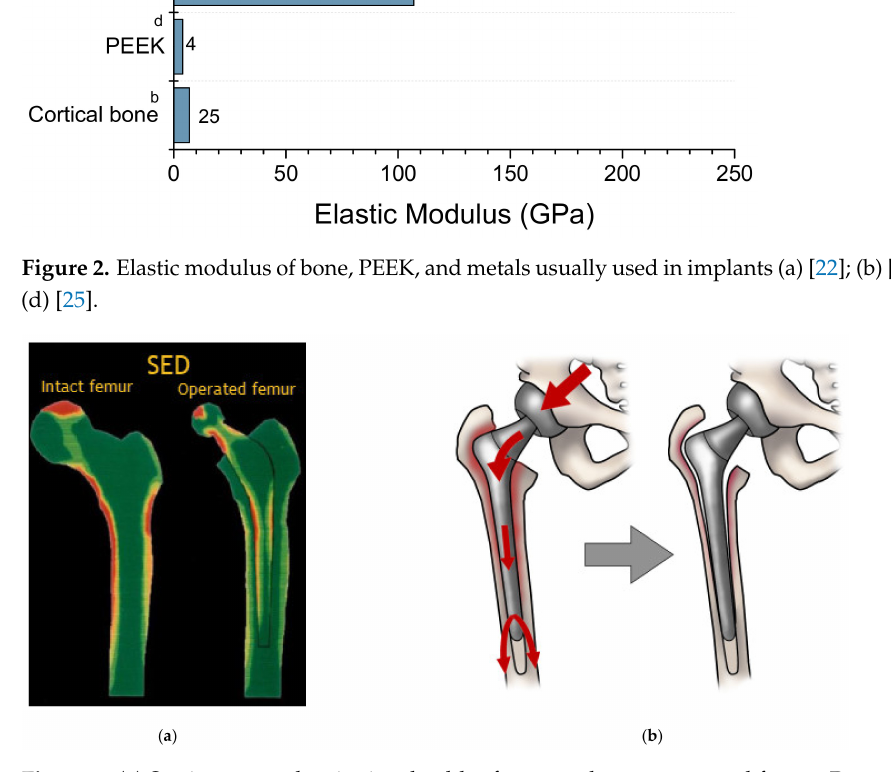
Figure 3. ( a ) Strain energy density in a healthy femur and on an operated femur. Reproduced with permission from [19]. Copyright 2015, Elsevier; ( b ) Schematic representation of stress shield and bone loss. Reproduced with permission from [26]. Copyright 2020,